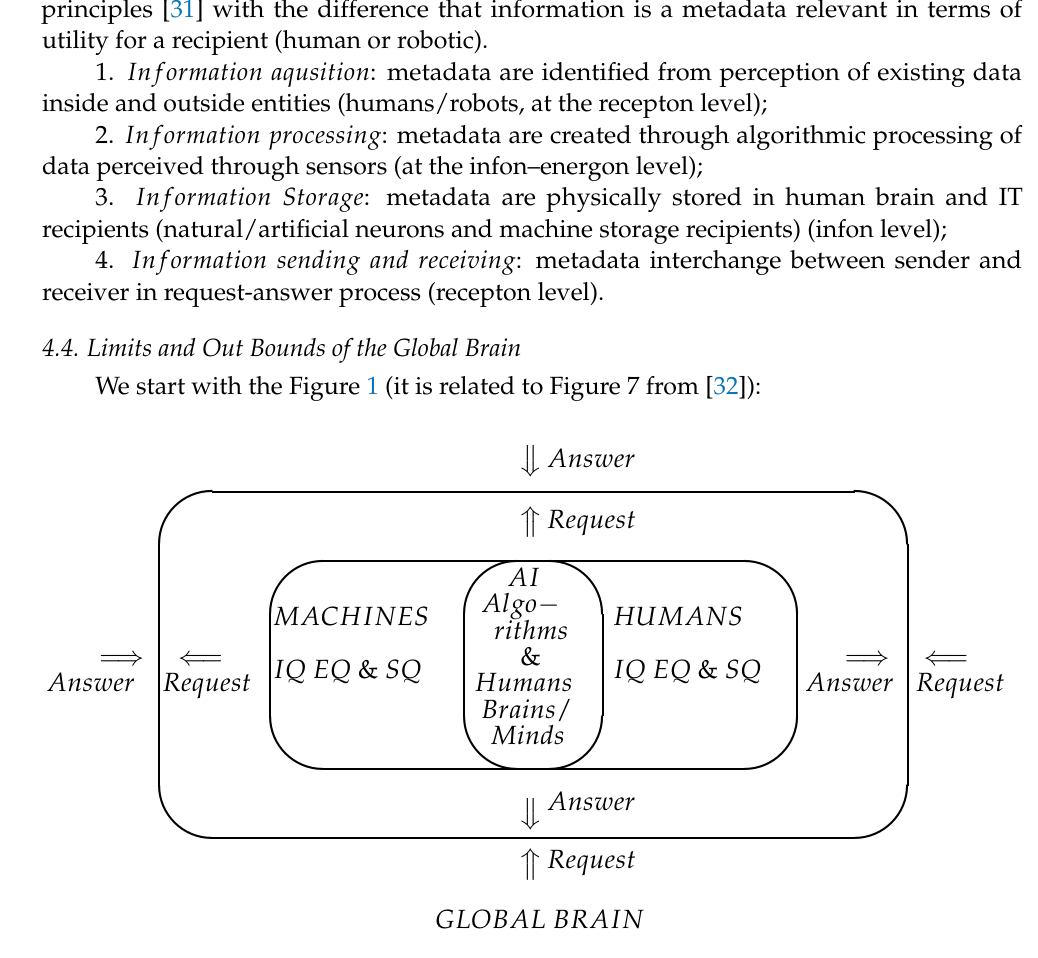
Figure1 . Machines ( AI Algorithms ) vs . Humans : a Global Brain Architecture Figure 1. Machines (AI algorithms) vs. Humans: a global brain